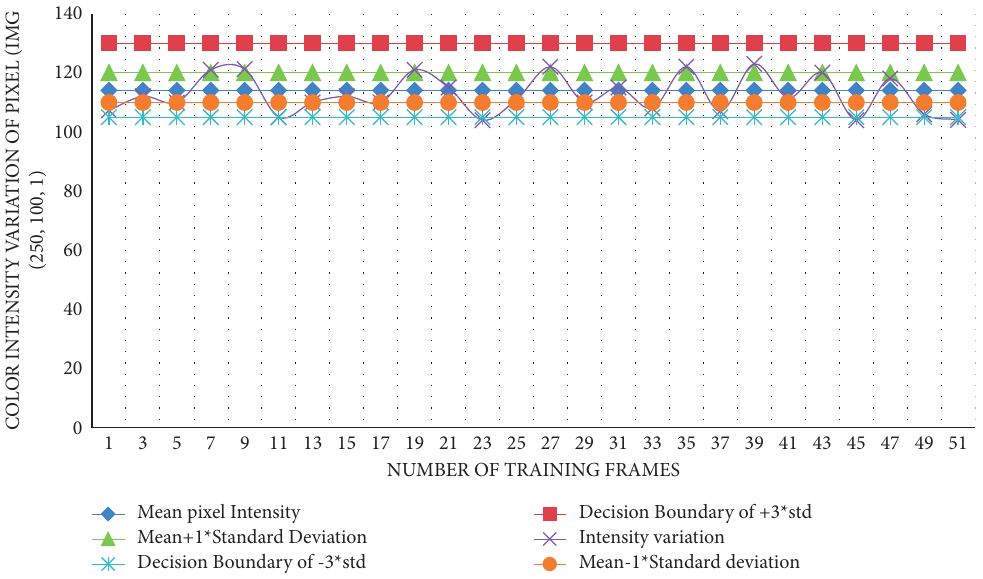
Figure 1: Graph representing the background model of pixels in different planes after